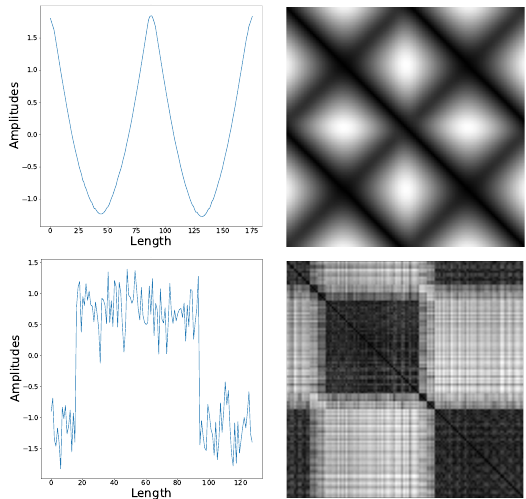
Figure 3. RP images of different sequences.The sequences come from ‘Adiac’ dataset (upper row) and ‘CBF’ dataset (lower row),